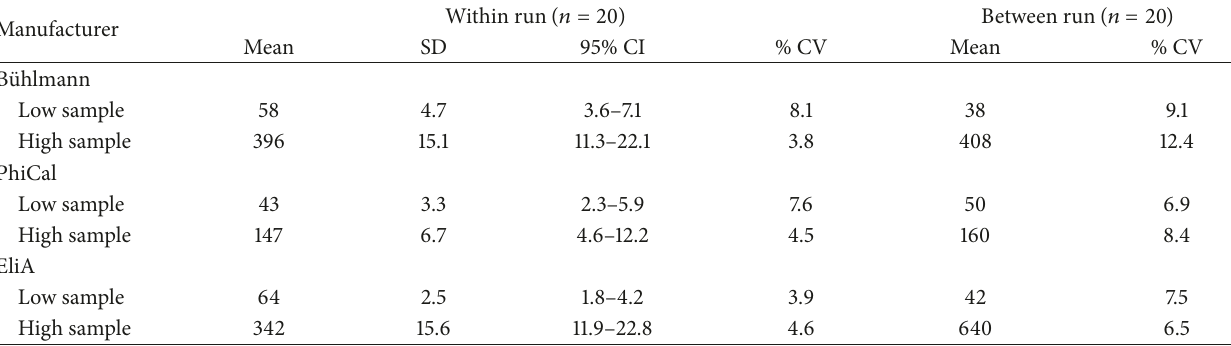
Table 2: Studied imprecision.